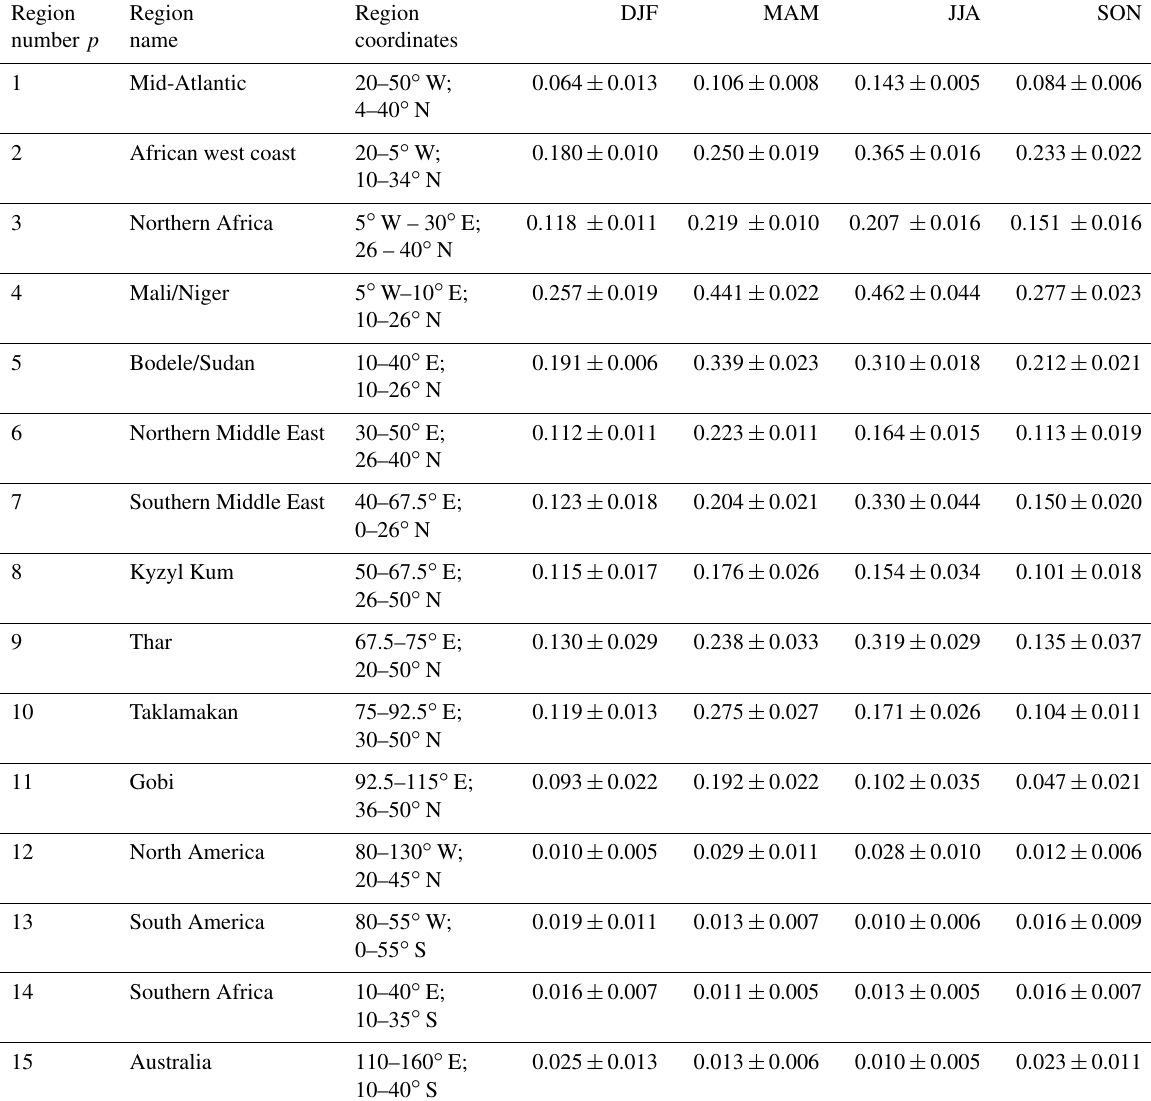
Table 2. Constraints on seasonal dust aerosol optical depth (DAOD) at 550nm averaged over 15 regions. Regional DAOD constraints for regions 1–11 are from Ridley et al. (2016) and were obtained using data from AERONET, MODIS, MISR, and a model ensemble. Regional DAOD constraints for regions 12–15 are from Adebiyi et al. (2020) and were obtained from an ensemble of aerosol reanalysis products. All constraints use data for the years